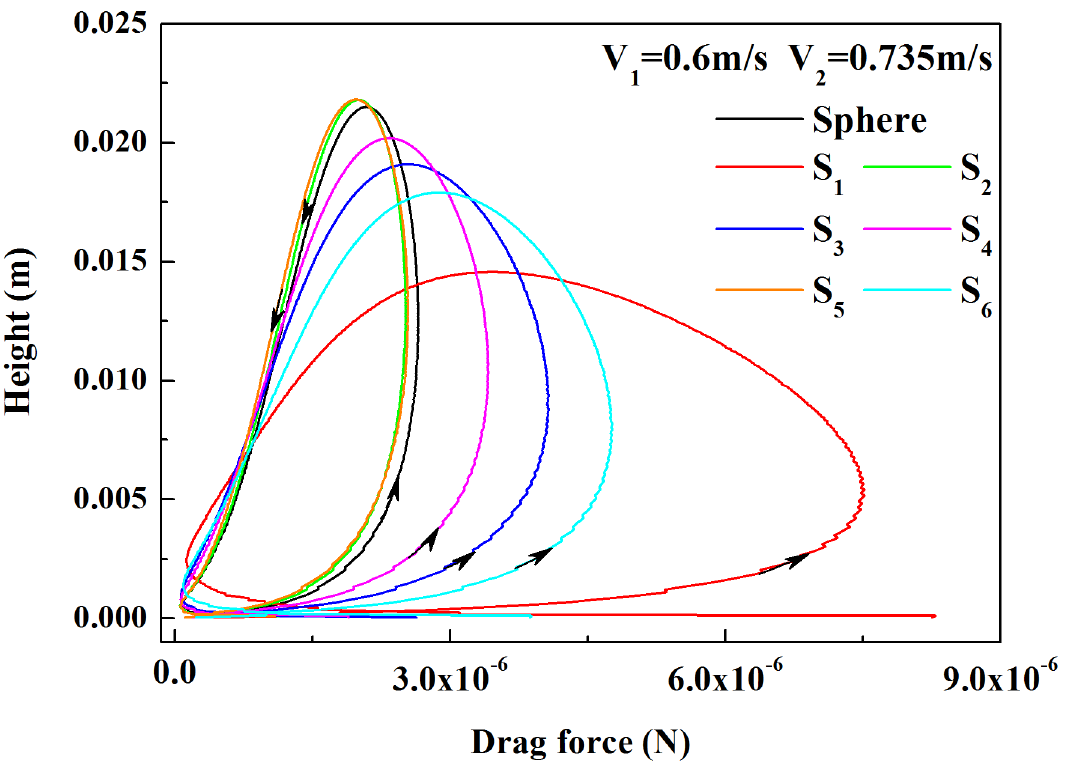
Figure 4. The drag force of different shaped particles with height. All the sand particles of different shapes take off with the same horizontal initial velocity of V 1 and vertical initial velocity of V 2 . The black solid line indicates spherical sand grains, S 1 and S 2 are two different ellipsoid-shaped sand particles, S 3 represents cube-shaped sand particles, S 4 and S 5 are two types of cylinder-shaped sand particles, and S 6 represents frustum- shaped sand particles.